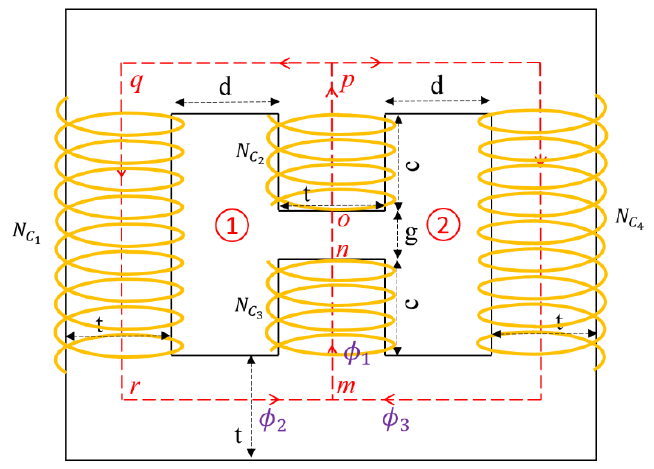
Figure 9. The H-shaped electromagnet with the path of magnetic flux penetration discretized by letters for magnetic analysis.